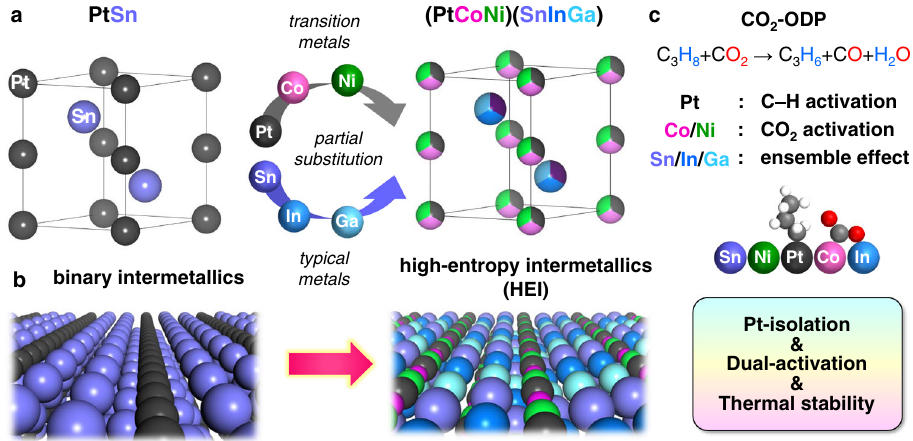
Fig.1|Aimofthiswork.a CatalystdesignconceptbasedonHEI.PtandSnsitesin intermetallic PtSn (hexagonal NiAs-type structure, space group: P6 3 /mmc) are partially substituted by Co/Ni and In/Ga, respectively, forming a PtSn-type HEI